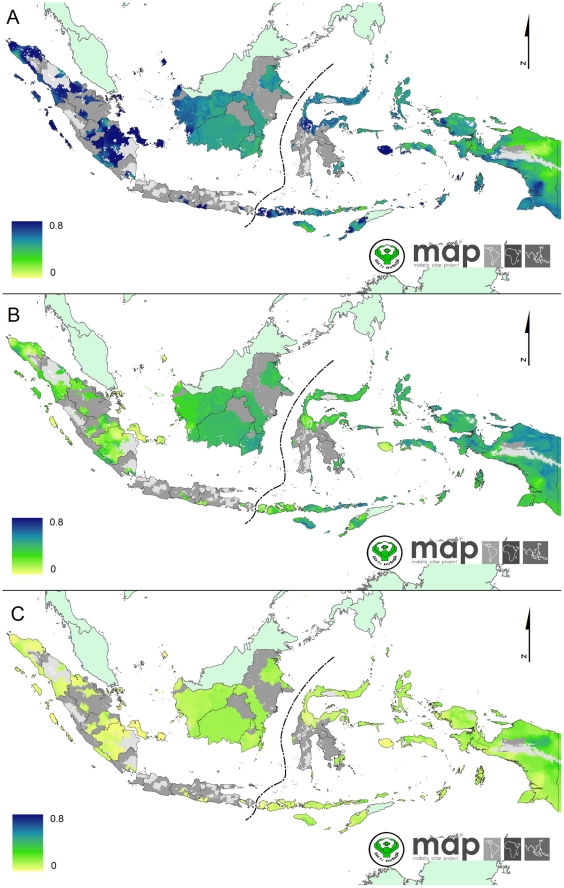
The predicted probability of PfPR2–10 falling in each endemicity class within the Plasmodium falciparum stable transmission areas.(A) The map of predicted probability of PfPR2–10 falling in the PfPR2–10≤5% endemicity class. (B) The map of predicted probability of PfPR2–10 falling in the 5%<PfPR2–10<40% endemicity class. (C) The map of predicted probability of PfPR2–10 falling in the PfPR2–10≥40% endemicity class.